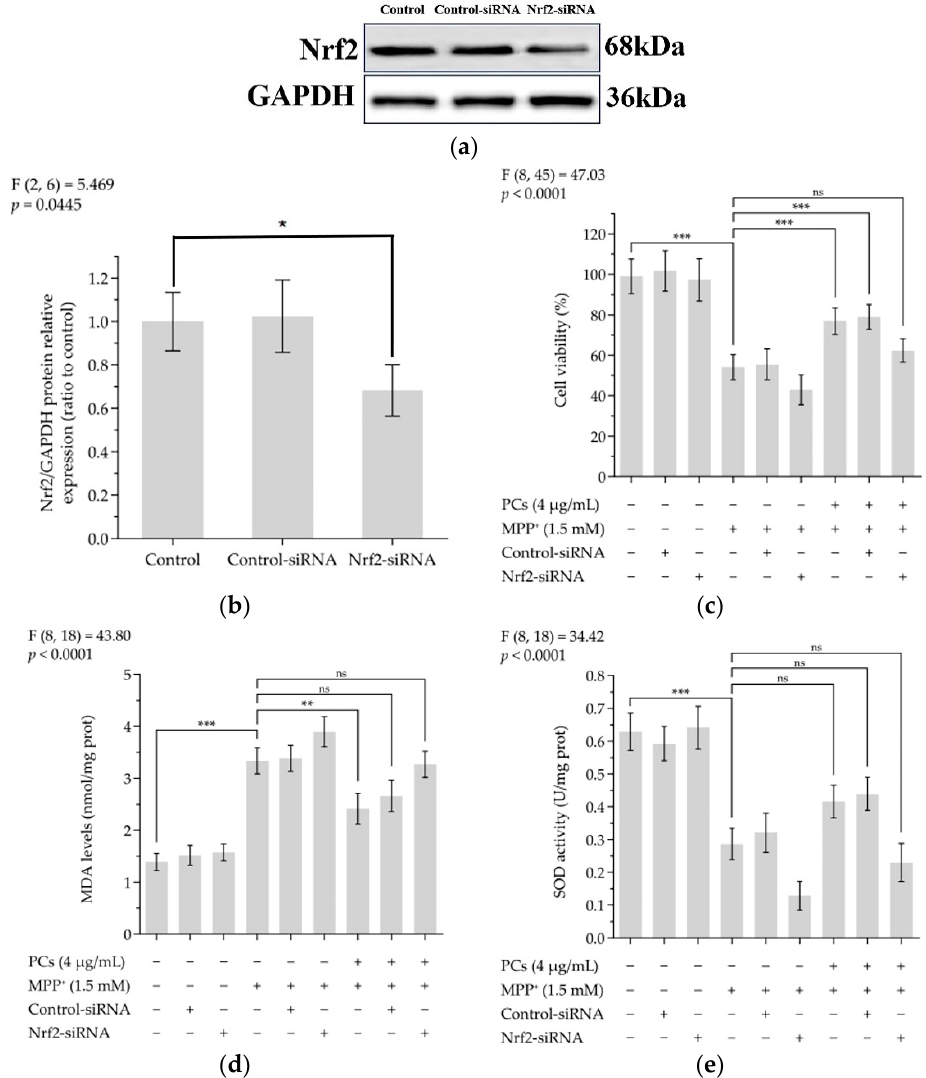
Figure 4. Nrf2/ARE signaling is related to the neuroprotective and antioxidant effects mediated by PCs. ( a ) Knockout efficiency was detected by determination of Nrf2 protein expression using Western blotting; ( b ) Nrf2/GAPDH protein relative expression (ratio to control); ( c ) Cell viability; ( d ) MDA levels; ( e ) SOD activity. F and p values of the one-way analysis of variance are presented above each chart. The results of Tukey’s post hoc test are presented for selected comparisons: ns, p > 0.05; *, p < 0.05; **, p < 0.01; ***, p < 0.001; the error bars are SD.